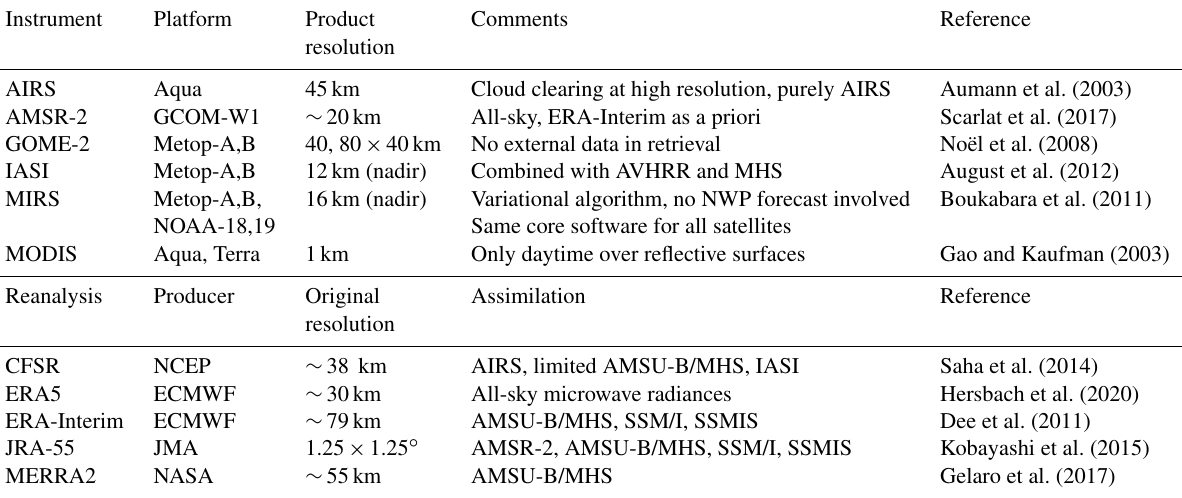
Table 1. Overview of water vapor products used in this study and their nominal resolution. Note that for cross-track imagers (e.g., IASI, MHS) the spatial resolution is highest for nadir and decreases with scan